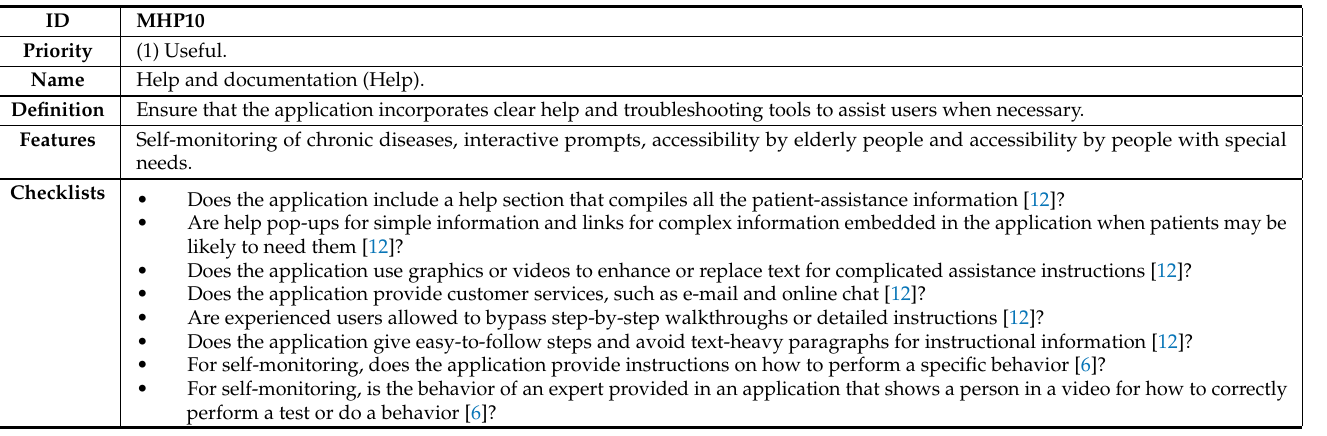
Table A10. Descriptive details of the tenth